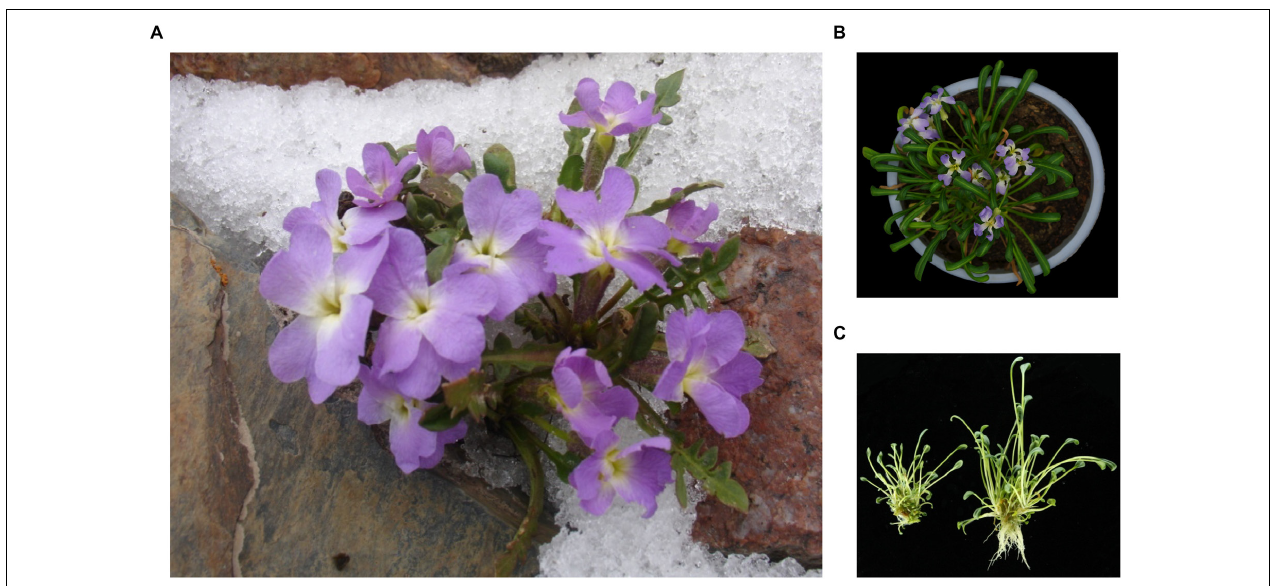
FIGURE 1 | Morphology of Chorispora bungeana . (A) Flowering stage of plants in their natural habitat (rocky mountains in snow). (B) Plants flowering in a growth chamber. (C) Regenerated seedlings from tissue